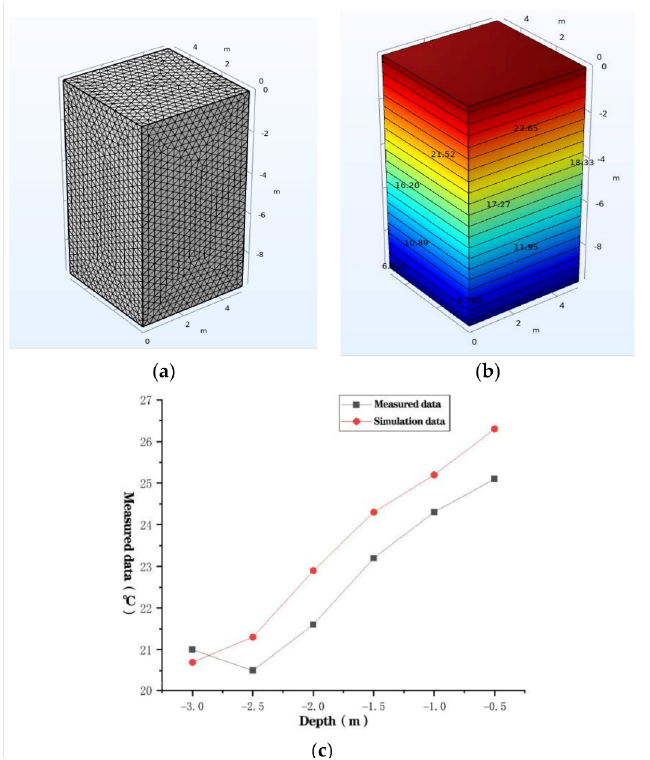
Figure 6. ( a ) Validation of model meshing. ( b ) Temperature simulation results. ( c ) Line graph of measured and simulated